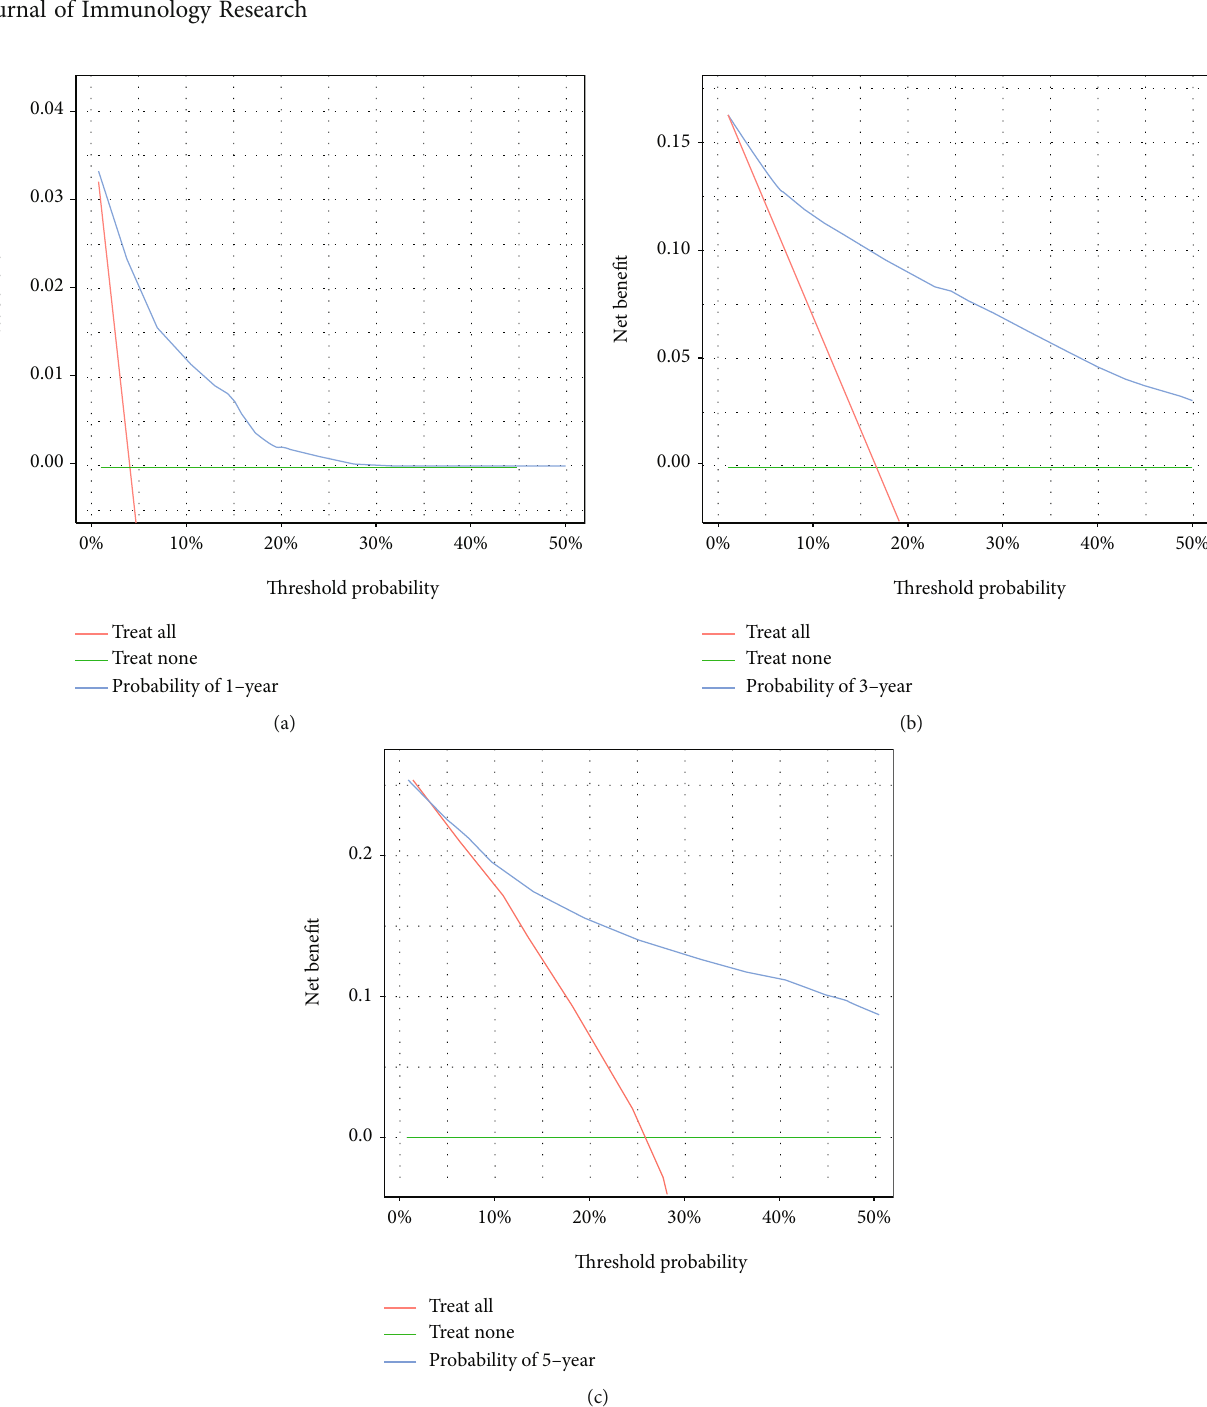
Figure 4: The decision curves in the training dataset (from left to right are the decision curves for the prediction of survival in year 1, year 3, and year 5,